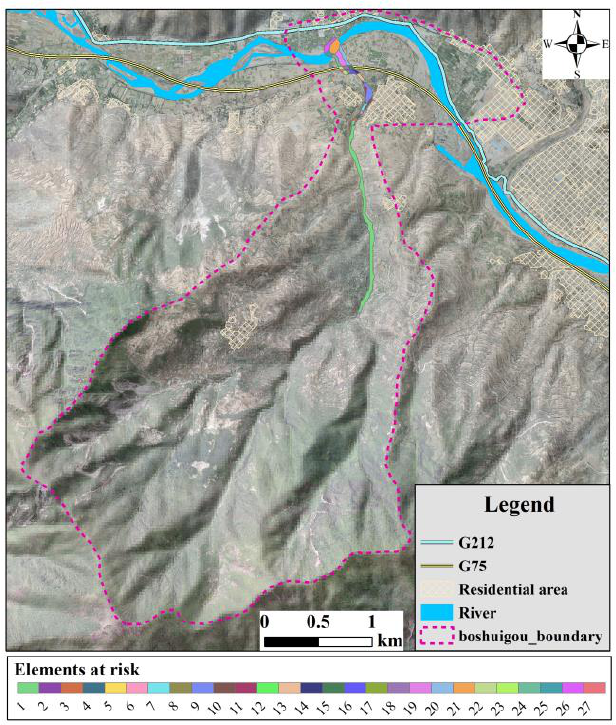
Figure 10. Detailed classification of elements at risk.